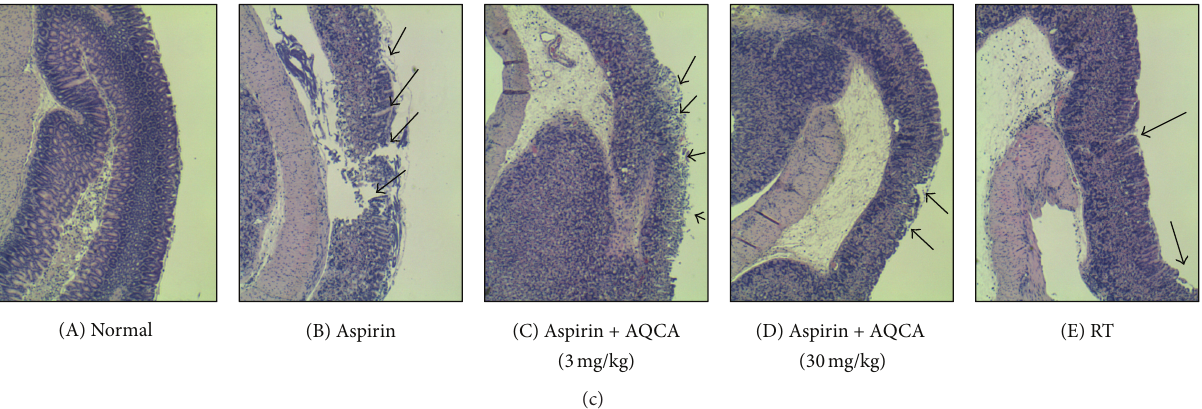
Figure 1: Effect of AQCA on in vivo inflammatory symptoms. ((a)(A) and (b)(A)) Mice were treated with orally administered AQCA (0, 3, and 30 mg/kg) or ranitidine (40mg/kg) for 3 days prior to oral administration of EtOH/HCl or aspirin (600mg/kg). After 24 h, gastric lesions in the stomach were measured using a pixel counter ((a)(B) and (b)(B)), and photographs of these lesions were taken using a camera ((a)(A) and (b)(A)). ((b)(B)) MPO activity, indicative of neutrophil infiltration in the stomach, was determined in total lysates of stomach from aspirin-treated mice administered with AQCA. (c) Histological examination of aspirin-treated stomach was performed by H&E staining after parafilm-fixed section. ∗ 𝑃 < 0.05 and ∗∗ 𝑃 < 0.01 compared with the control group.